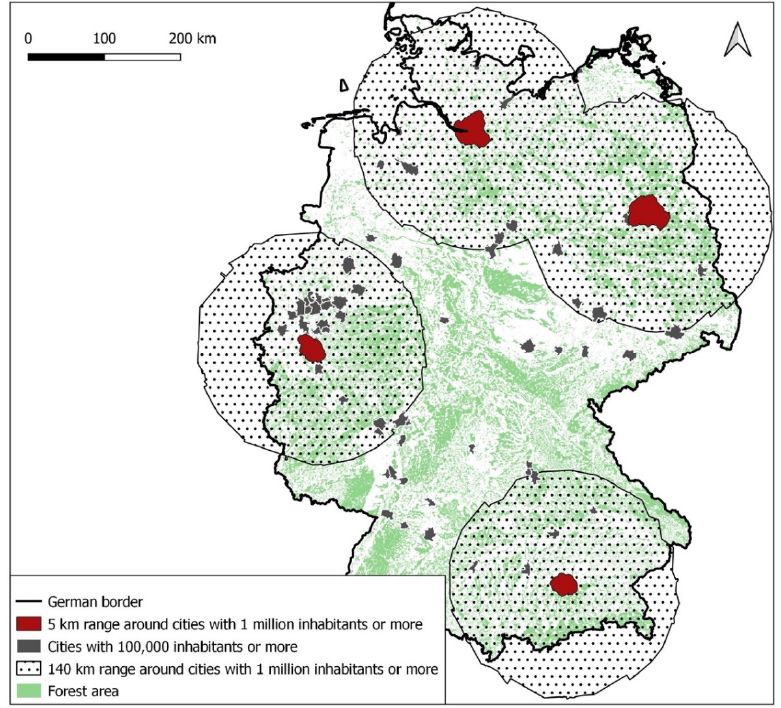
Figure 2. Map of Germany with buffer zone goals around the four major cities with 1 million or more population. The greatest risk is to the urban centers in a range of 5 km around the target area.